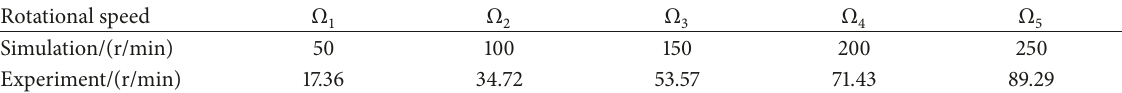
Table 4: Speed of the experiment and the simulation.